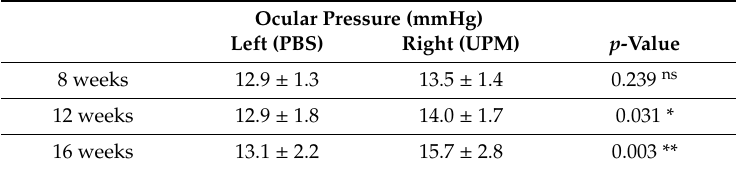
Table 1. E ff ect of long-term exposure to UPM on ocular